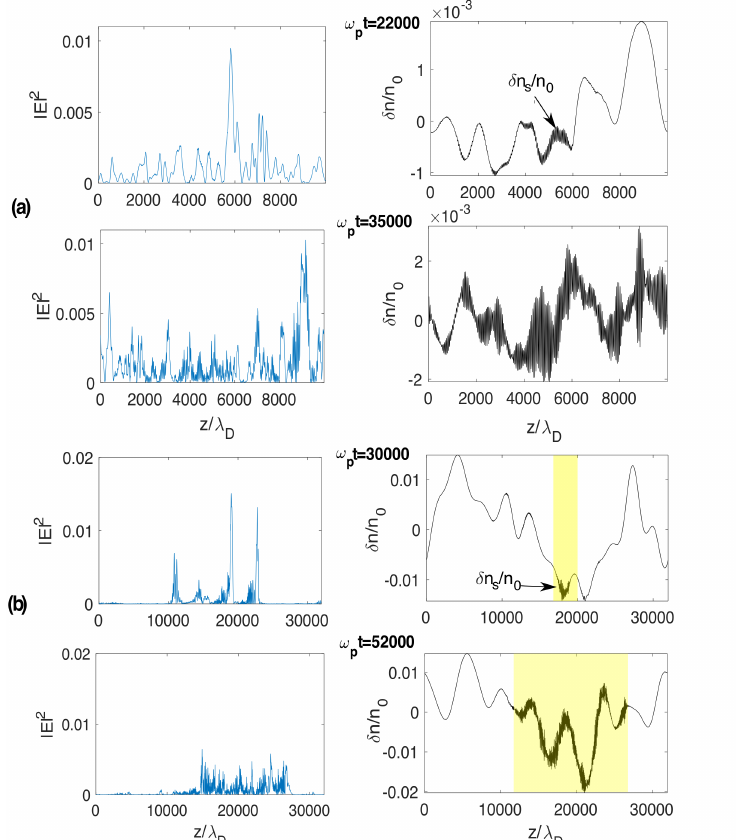
Figure 7. ( a ) ( Left panels): profiles along the coordinate z / λ D of the normalized wave energy density | E | 2 at times ω p t = 22,000 and ω p t = 35,000. ( Right panels): corresponding profiles of the density fluctuations δ n / n 0 ; short-scale oscillations δ n s / n 0 are growing with time. The main parameters are the following: n b / n 0 = 5 × 10 − 5 , v b / v T = 14, ∆ n = 0.001. ( b ) ( Left panels): profiles of the normalized wave energy density | E | 2 at times ω p t = 30,000 and ω p t = 52,000. ( Right panels): corresponding profiles of the density fluctuations δ n / n 0 ; the localized regions of growth of the short-scale oscillations δ n s / n 0 are colorized. The main parameters are the following: n b / n 0 = 2 × 10 − 5 , v b / v T = 18, ∆ n = 0.01. All variables are